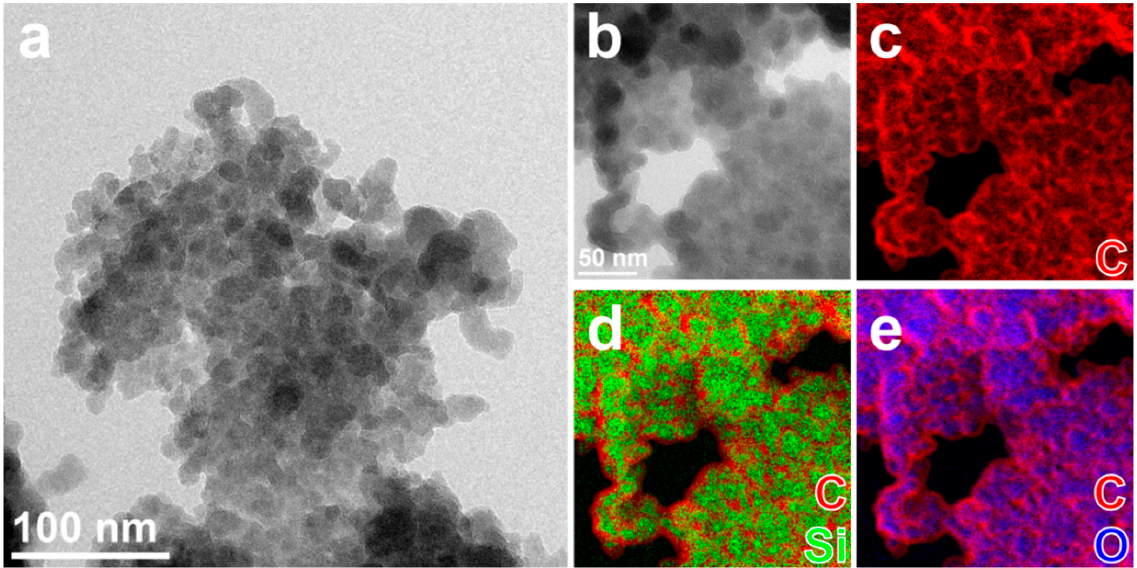
Figure 2. ( a , b ) Elastically filtered BF-TEM images of aggregates of nanoparticles of CQD-RHA@SiO 2 , partly suspended on holes in the carbon support film, and ( b ) zoomed-in area and ( c – e ) combina- tions of EF-TEM compositional maps for Si (green), O (blue), and C (red) acquired in the same ag- gregate.